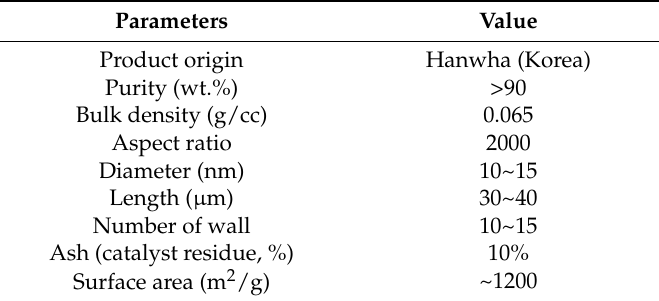
Table 3. Properties of